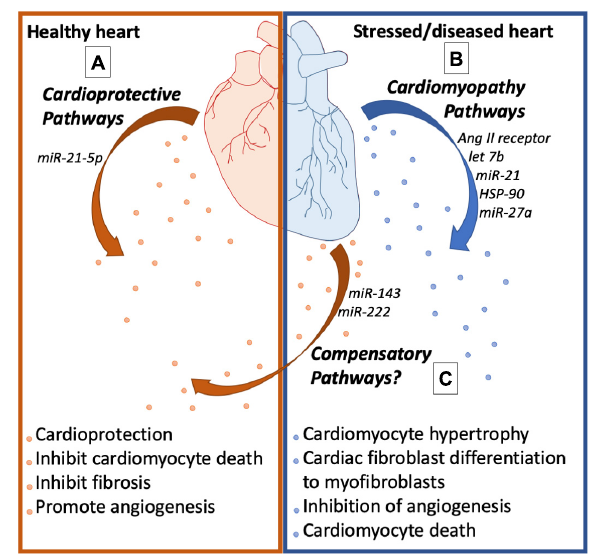
FIGURE 3 | Cardiac health affects exosome biology. (A) Exosomes from the healthy heart are enriched with cardioprotective molecules that promote angiogenesis, inhibit fibrosis, and inhibit cardiomyocyte cell death. (B) Exosomes from the stressed heart release exosomes enriched with molecules that cause cardiomyocyte hypertrophy, myofibroblast differentiation, endothelial dysfunction, and cardiomyocyte cell death. (C) The stressed heart also releases exosomes that activate compensatory pathways to promote cardiac health.